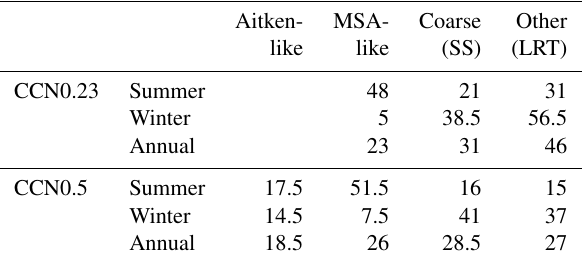
Table 1. Fractional contribution to CCN at 0.23 and 0.5% supersat- uration from current analyses. Aitken- MSA- Coarse Other